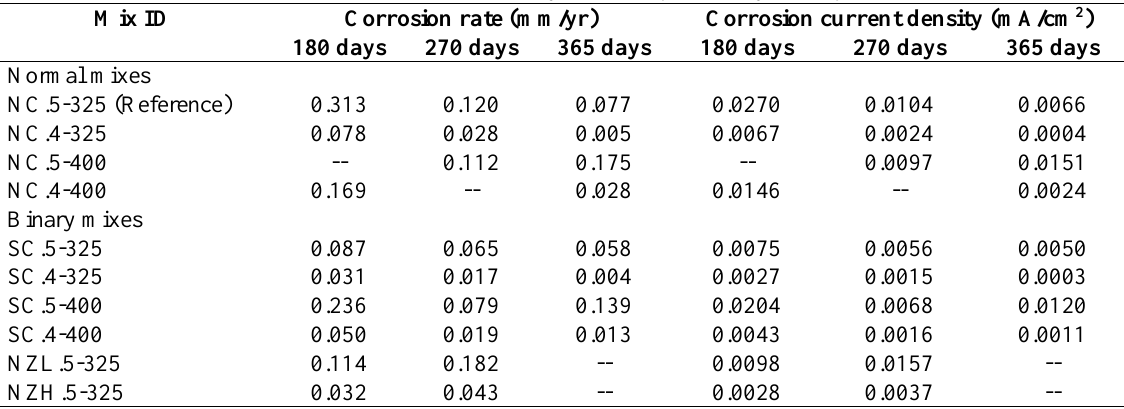
Fig. 3. Schematic of four electrode setup for electrochemical measurements Table 7. Corrosion rate and current density based on potentiodynamic polarization